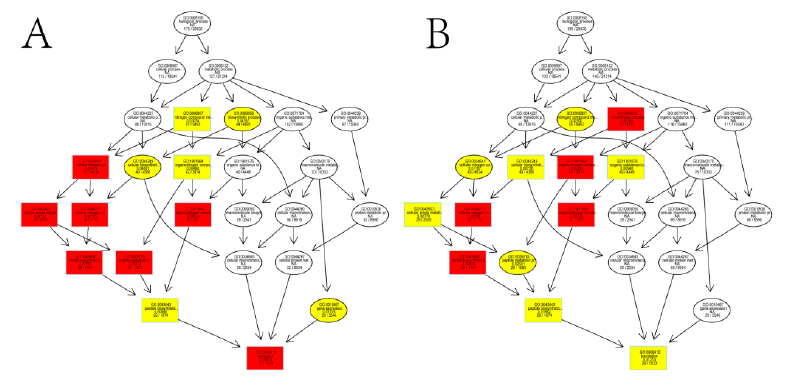
Figure 4. The noteworthy GO terms for both the flower bud ( A ) and stem apex ( B ). DEGs pertained to functions related to nitrogen compound biosynthesis and metabolism.